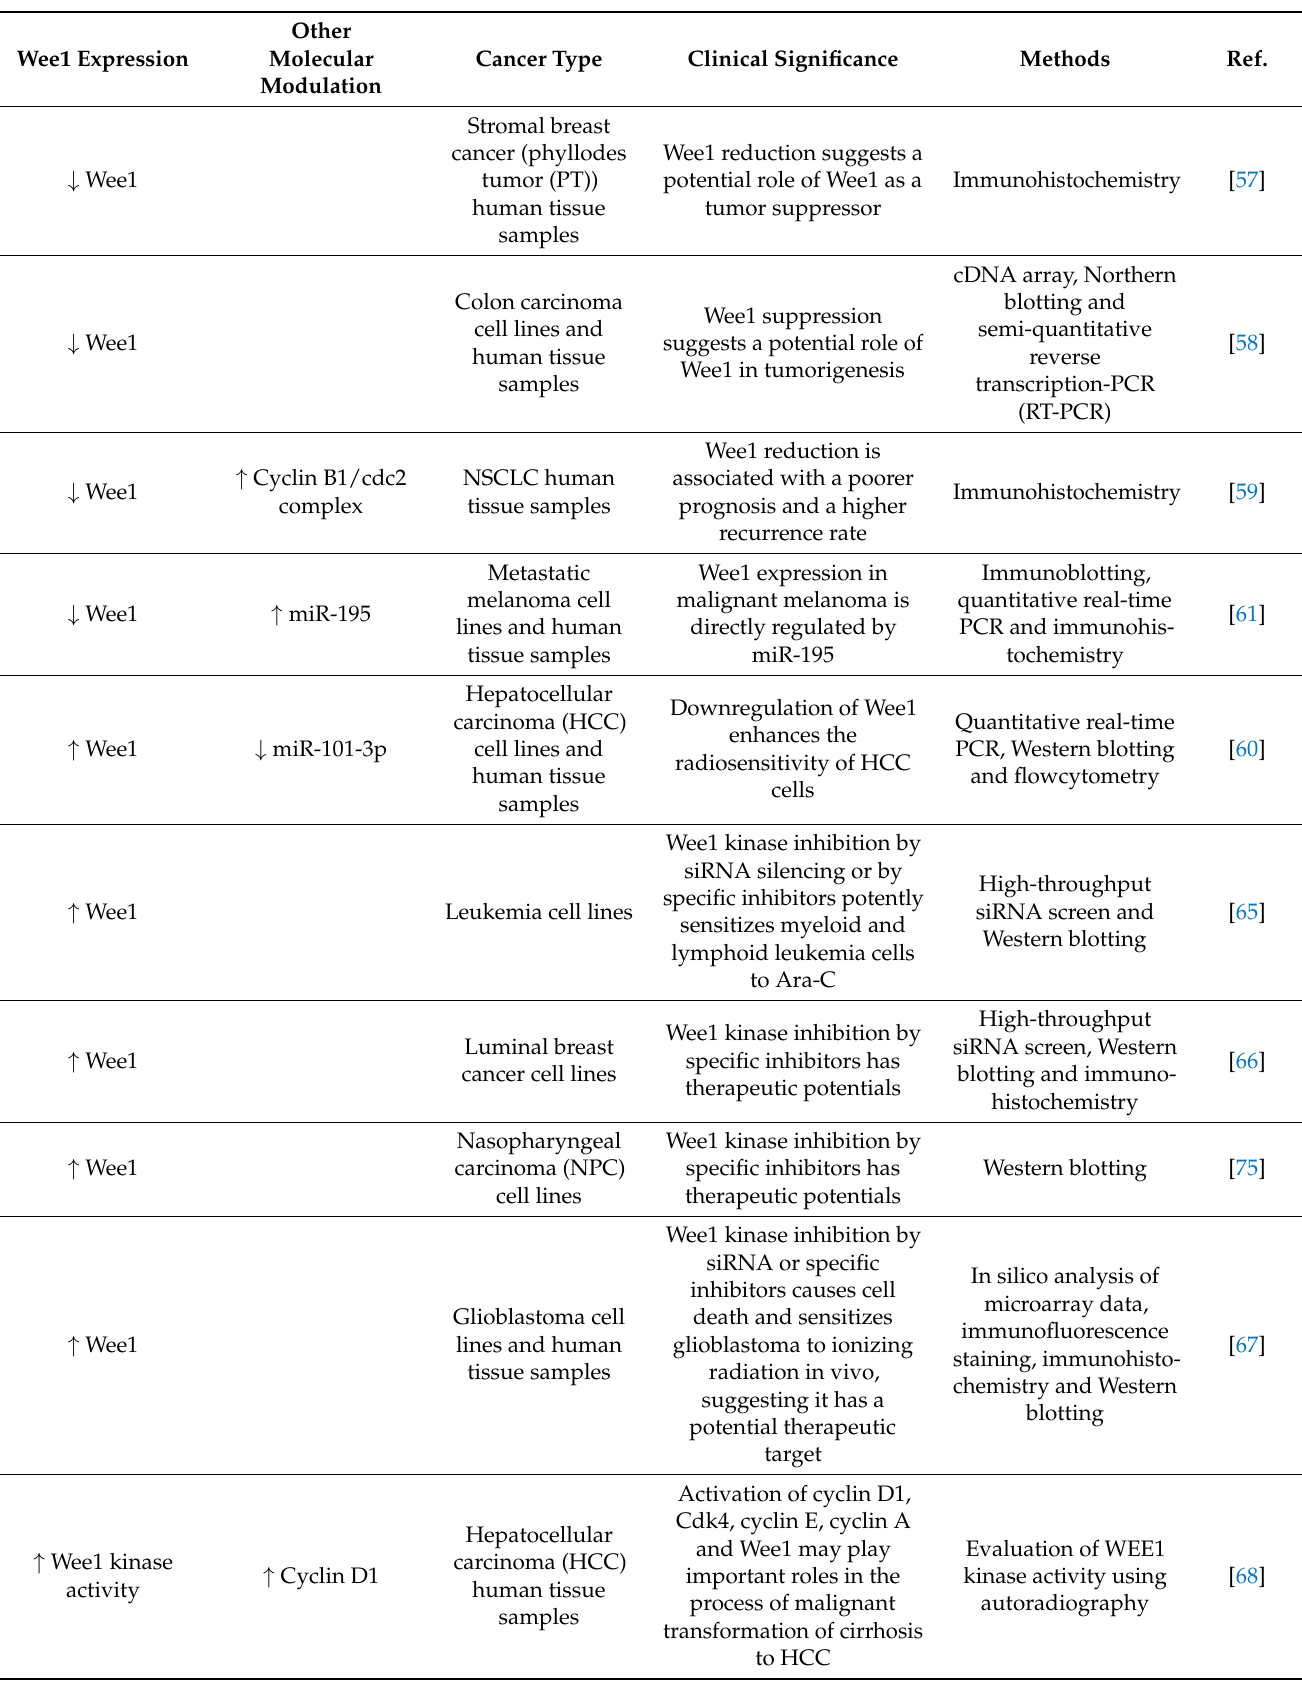
Table 1. Bibliographic evidence about Wee1 expression in different cancer